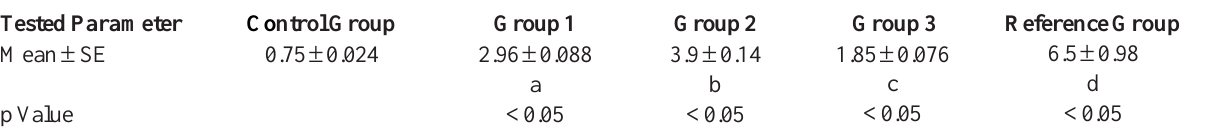
Table 1 – Mean free serum testosterone level (pg/ mL) among groups of rats treated with 70% alcoholic extracts of Tribulus alatus.